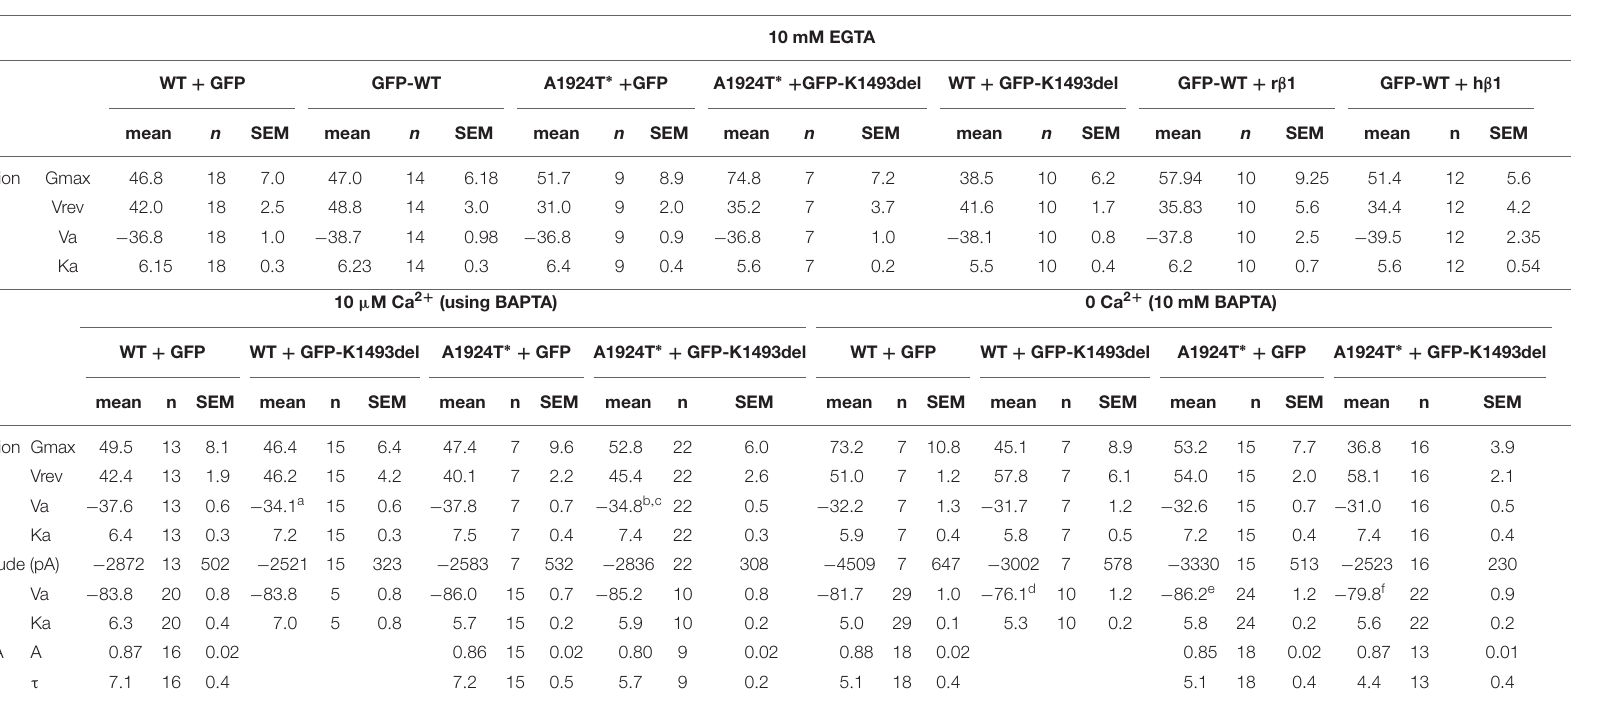
TABLE 2 | Gating properties of Na V 1.5 in different Ca 2 +